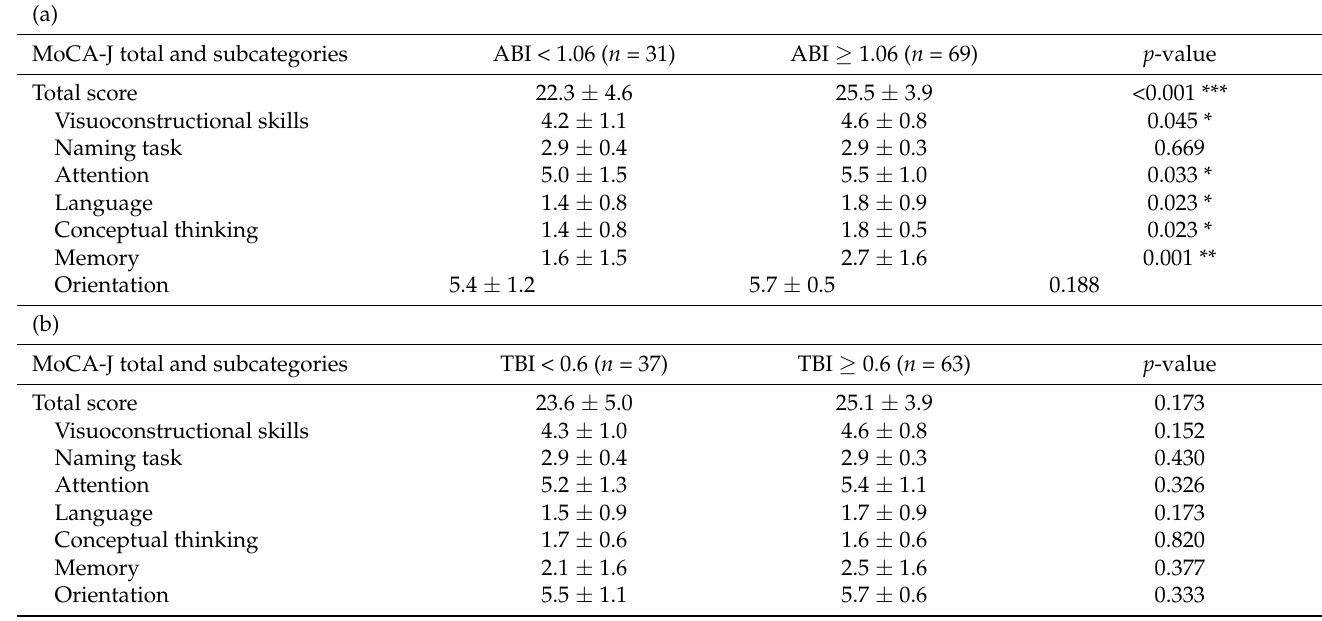
Table 2. Comparison of MoCA - J scores in two groups divided by ( a) ABI and ( b) TBI cutoff values .